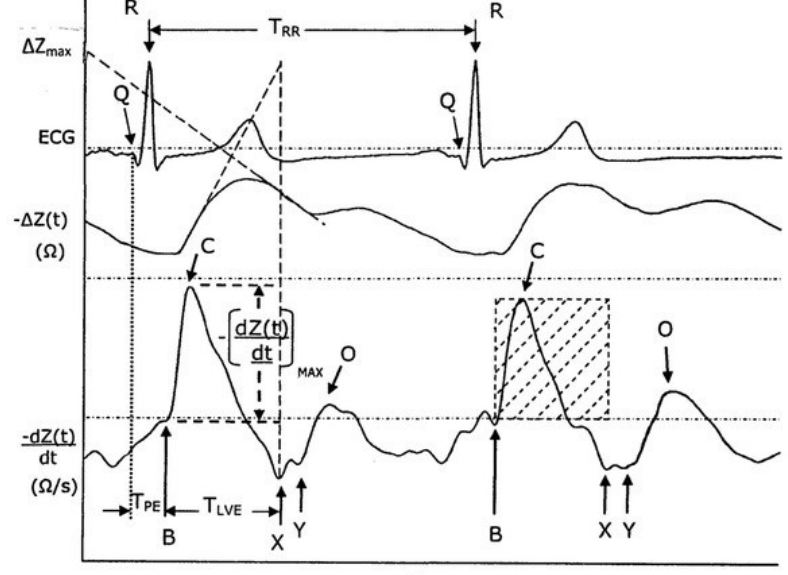
Fig. 1: ICG plotted as change in impedance (-ΔZ), the time-derivative of the impedance (-dZ/dt) together with ECG. The B point marks the aortic valve opening, the X point marks aortic valve closure, the Y point marks pulmonic valve closure and the O point marks the rapid ventricular filling wave. The distance from the ECG Q-point to the ICG B point is attributed to the pre-ejection period of the heart (TPE), and the ICG B-X distance is attributed to the left ventricular ejection time (TLVE). The figure is copied from Bernstein 2009 under the Wikimedia Commons